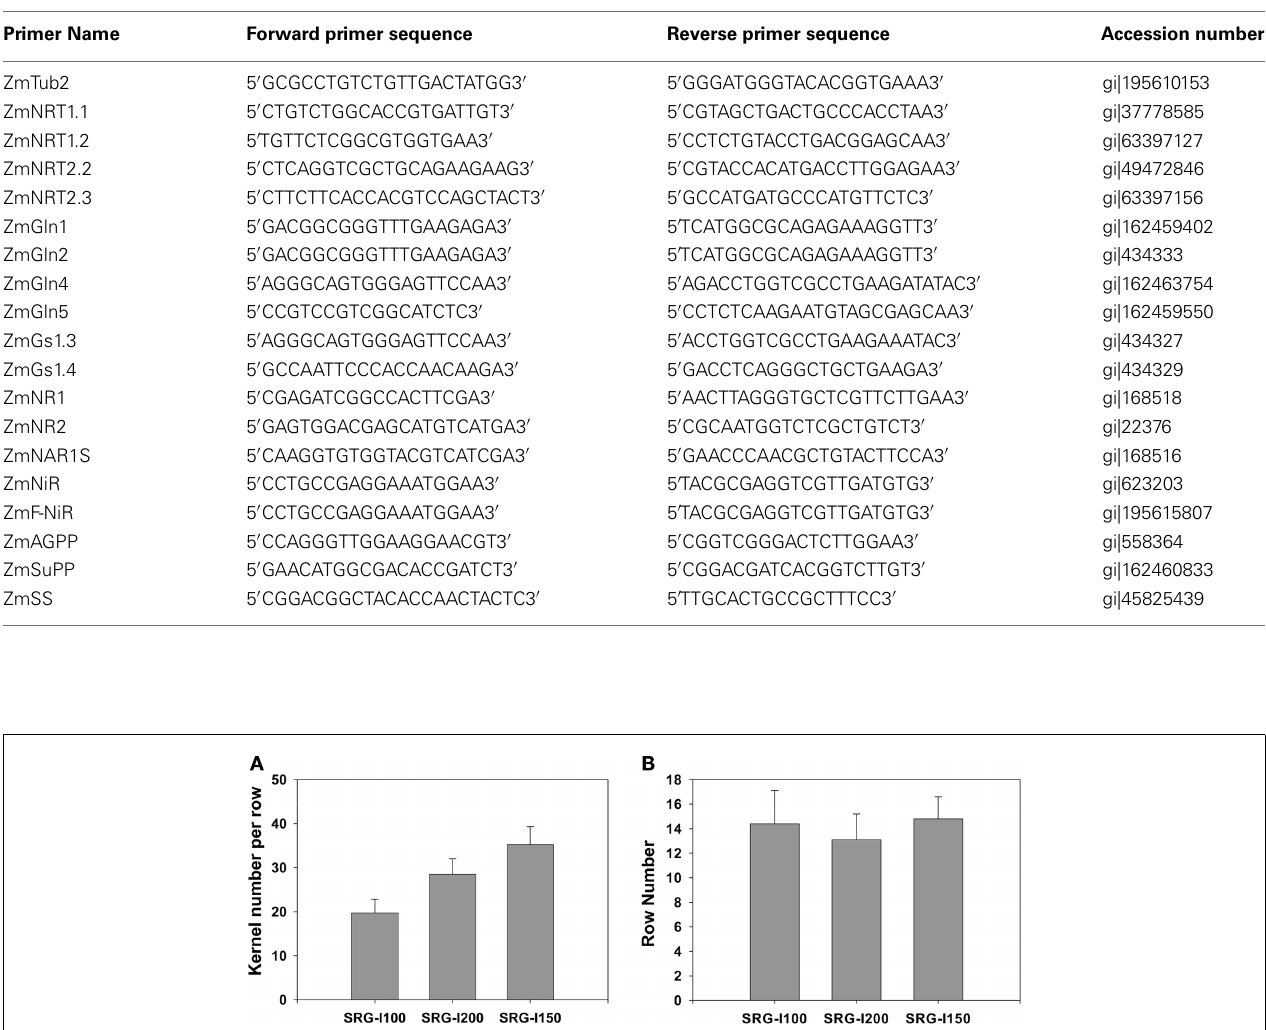
TableA1 | Primers sequences used in performing the real-time PCR.